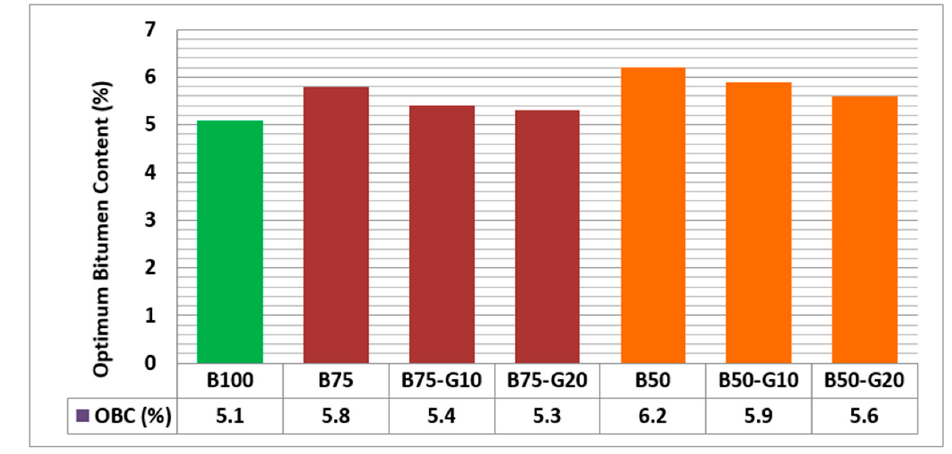
Figure 12. Optimum bitumen content (OBC) of asphalt mixtures.